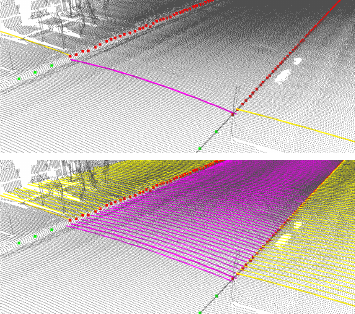
Figure 6: Up: surface model of the first slice in purple and yellow. Down: surface model of successive slices. 2 usually and 3 in crossroads, see further). The same process is discretizations of road and pavement surface polynomials.